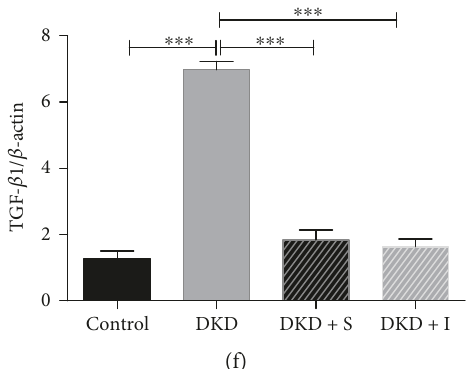
Figure 5: SYFSF inhibited renal fi brosis in DKD rats. (a – d) Immunohistochemical staining of TGF- β 1, collagen IV, and fi bronectin is shown. (e, f) Western blot and quantitative analysis of TGF- β 1 in the cortex. SYFSF and irbesartan inhibited the expression of TGF- β 1 in DKD rats. DKD+ S represents the DKD rats treated with SYFSF. DKD +I represents the DKD rats treated with irbesartan. ∗ P < 0 05 , ∗∗ P < 0 01 , and ∗∗∗ P < 0 001 .